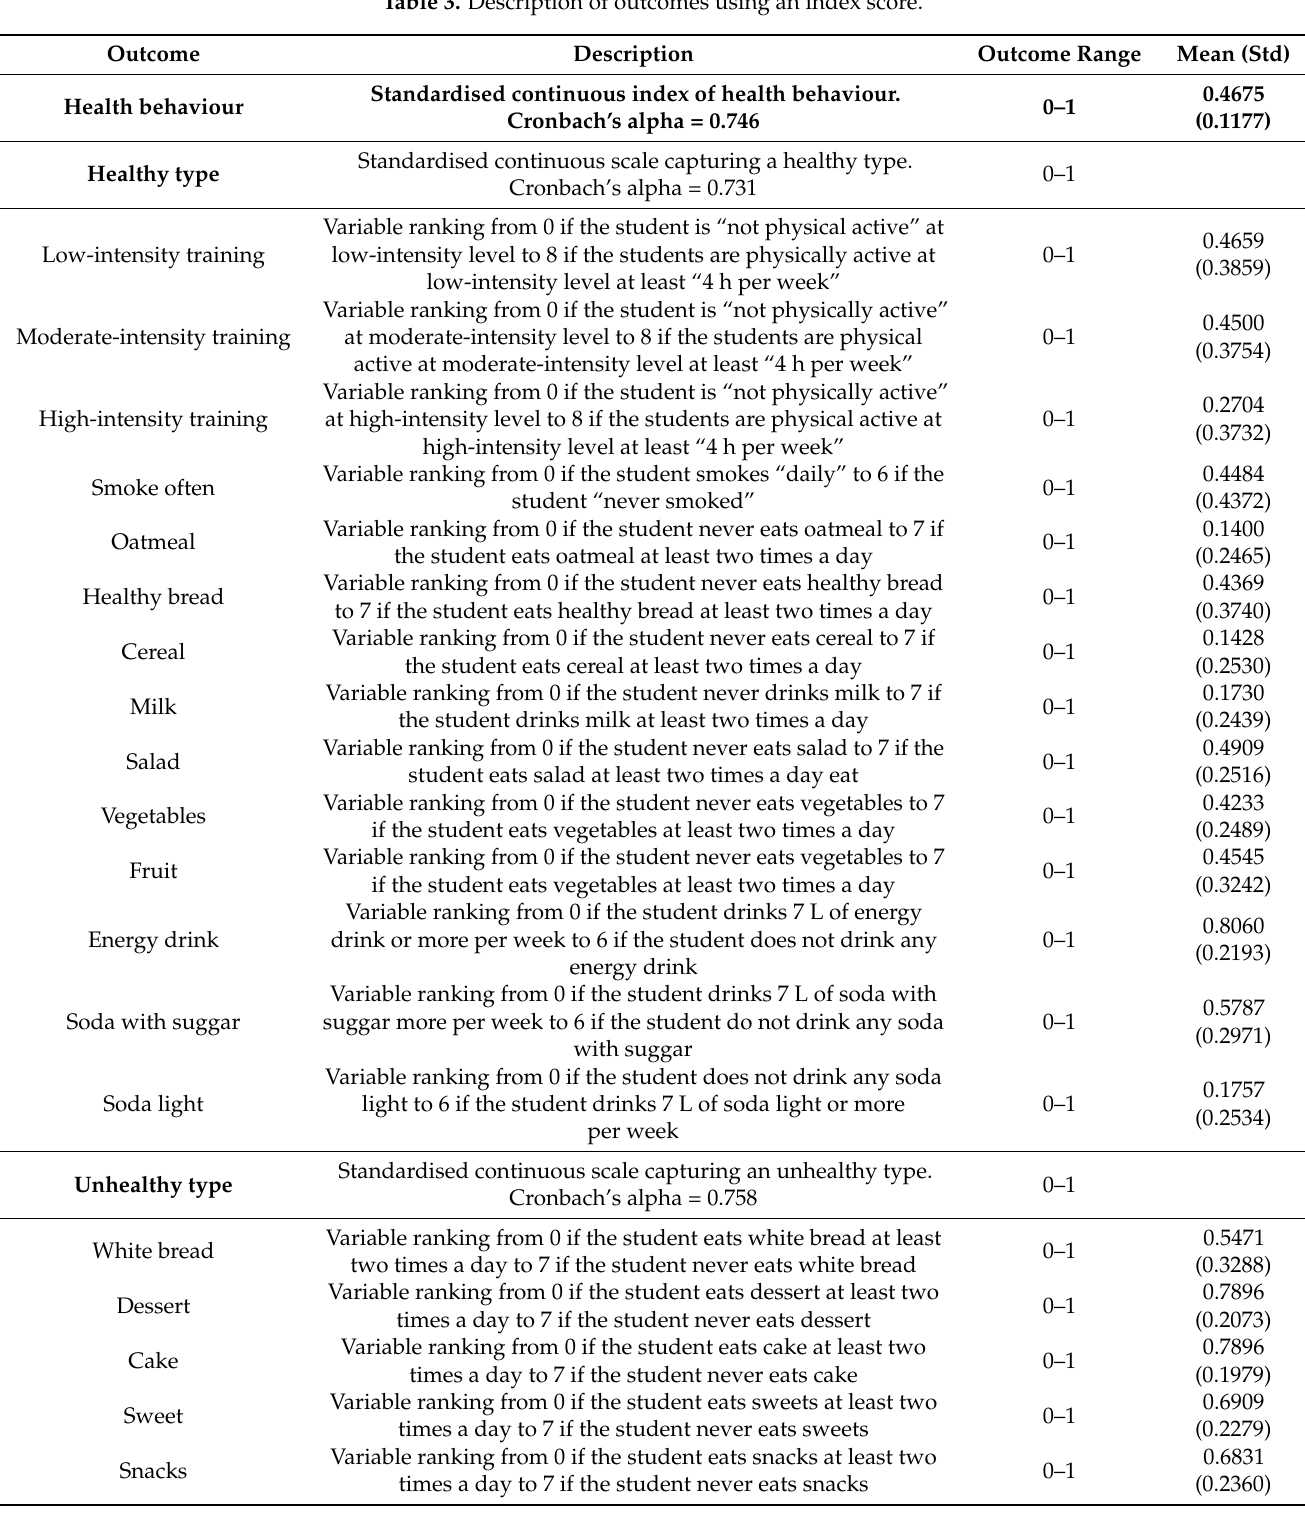
Table 3. Description of outcomes using an index